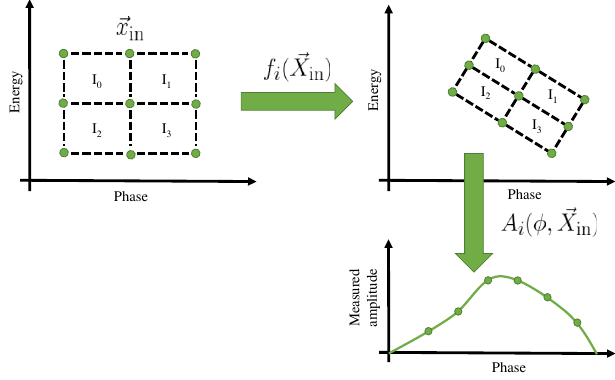
⃗ X is transported trough the in ⃗ X in Þ